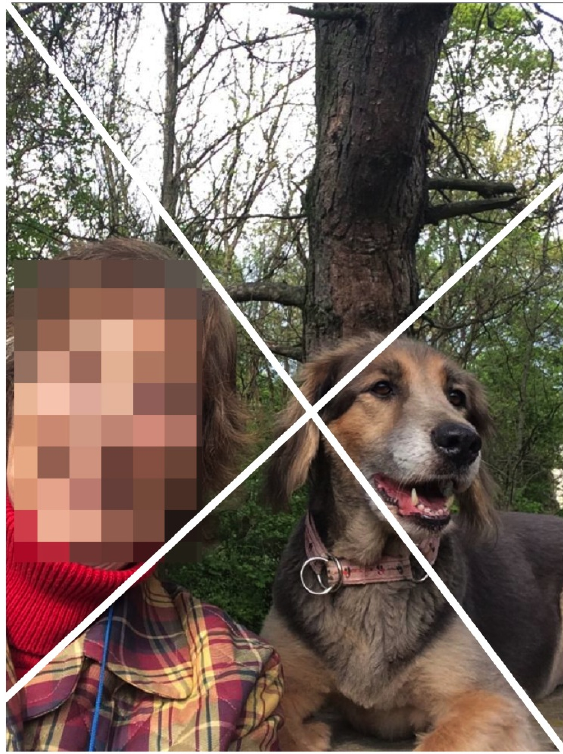
Figure 5. Compositional structure of picture, marked by author.